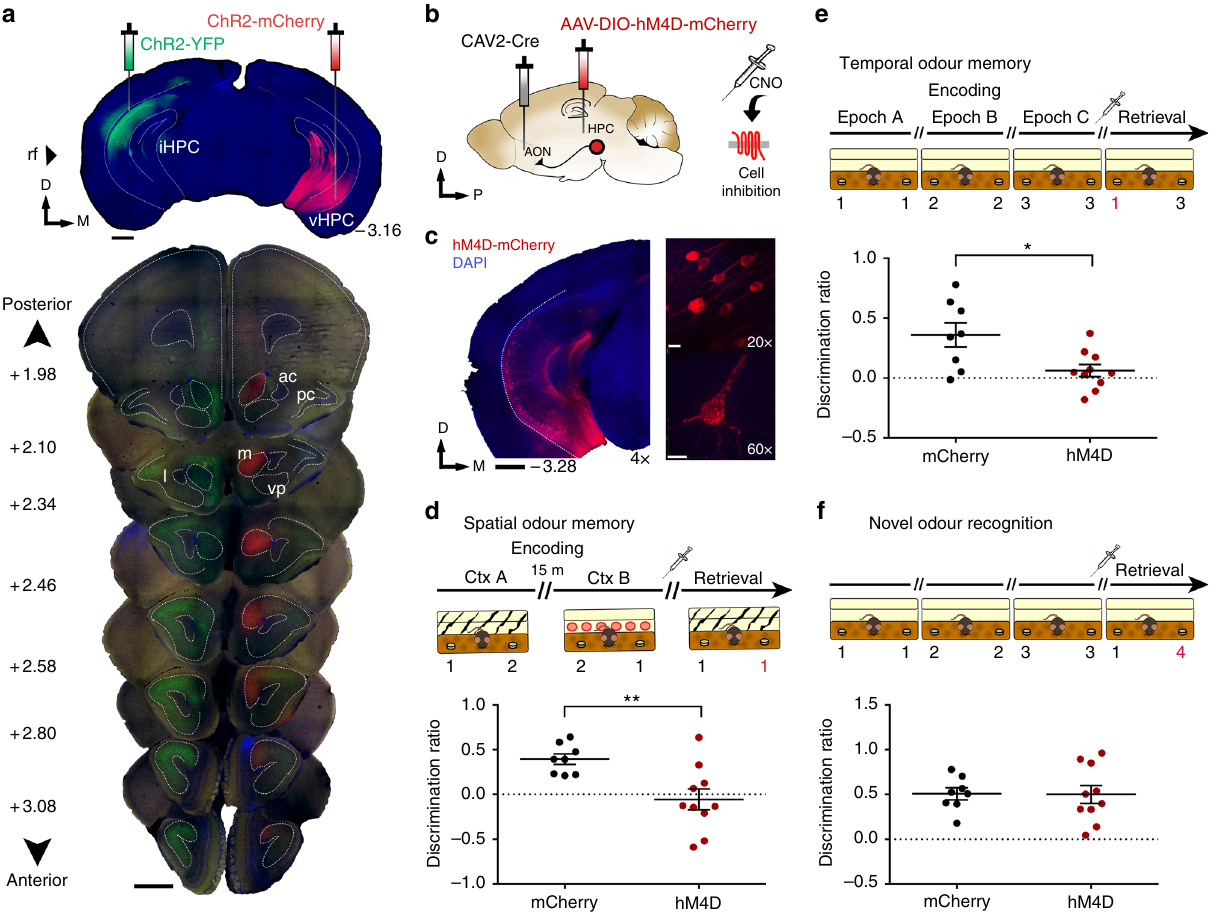
Fig. 1 Inhibition of AON-projecting hippocampal neurons impairs context-dependent odour memory recall. a Coronal section depicting site of AAV-ChR2- YFP and -mCherry injections in the hippocampus (top) and the resulting innervation pattern at the AON (bottom). Coordinates mark anteroposterior position from bregma. Scale bars represent 1 mm; ac, anterior commissure; pc, piriform cortex; l, lateral AON; m, medial AON; vp, ventroposterior AON. b Schematic diagram depicting experimental approach. CAV2-Cre was infused into the AON, whereas Cre-responsive AAV-hM4D-mCherry was injected in the hippocampus. c Representative sections depicting AON-projecting HPC neurons expressing hM4D-mCherry. Magni fi cation is indicated on the bottom right of each panel. Scale bars represent 1 mm (black) or 10 μ m (white). d The olfactory spatial memory test paradigm. CNO-treated hM4D mice investigated the familiar and novel odour location to a largely equal extent, indicative of impaired spatial odour memory (Independent-samples t -test, t = 3.194, ** P < 0.01). e The olfactory temporal order memory test paradigm. CNO-treated hM4D mice were impaired in memory for the temporal (16) occurrence of encountered odours (Independent-samples t -test, t (16) = 2.795, * P < 0.05). f Both groups showed normal performance in a